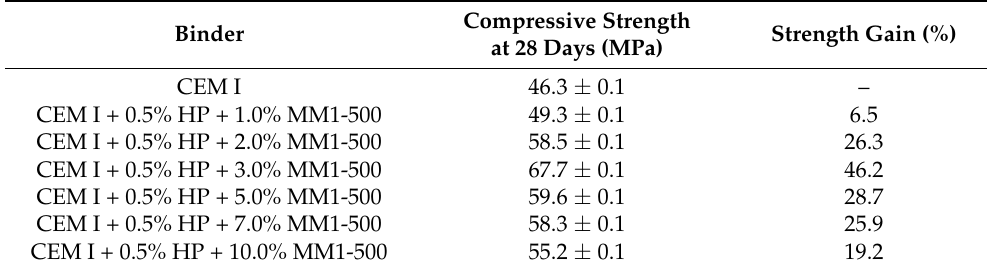
Table 9. Dependence of the compressive strength of the composite binder on the dosage of the mineral